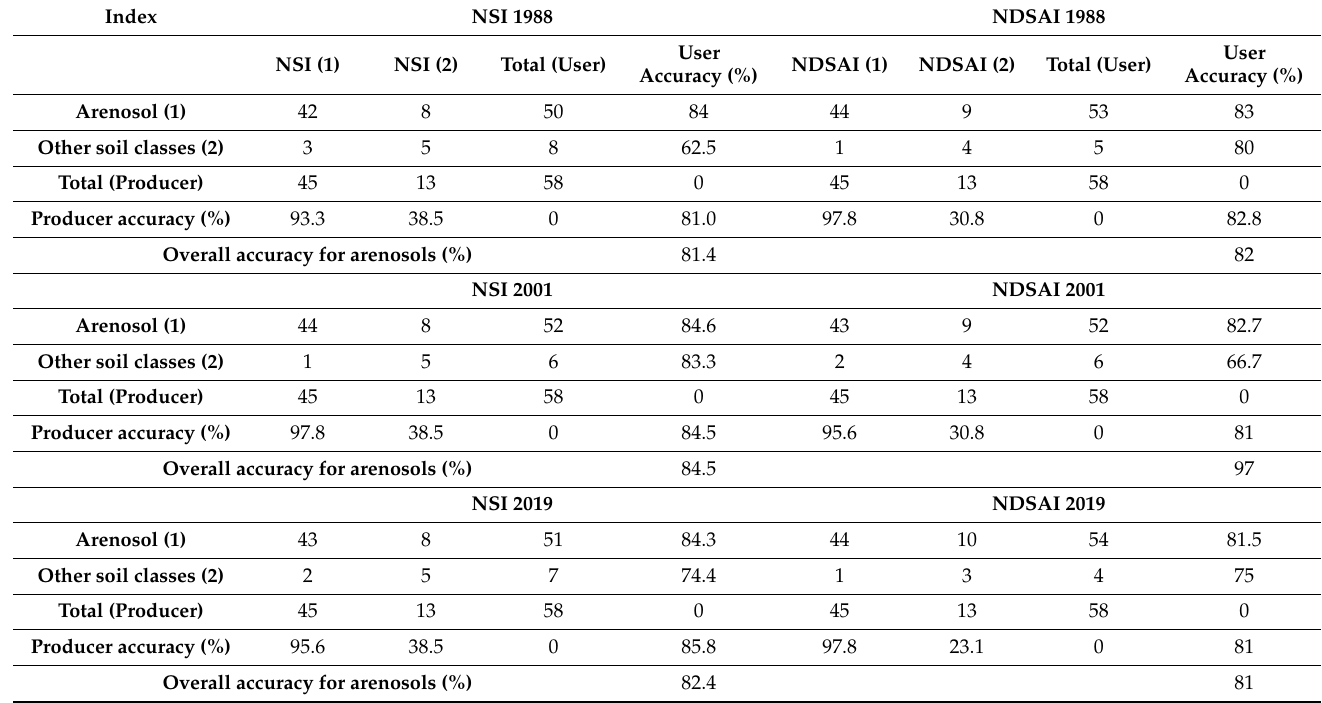
Table 5. NSI and NDSAI calibration accuracy analysis for